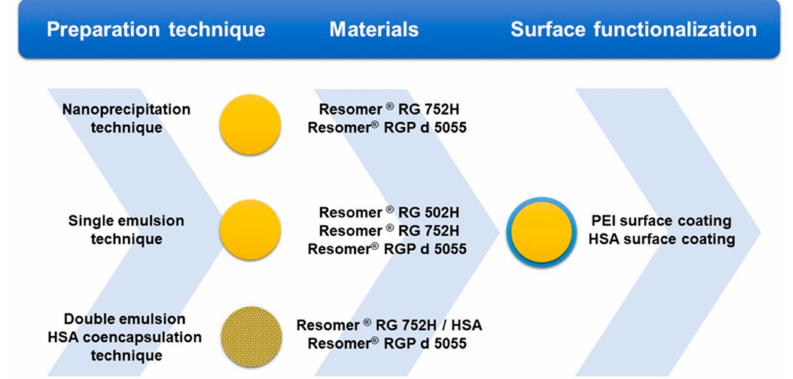
Figure 1. Scheme of the nanoparticle preparations with the preparation technique, materials used, and surface functionalization (from the left to the right). Each preparation technique was evaluated with the presented materials. Surface coating was undertaken for preparations manufactured by single emulsion technique